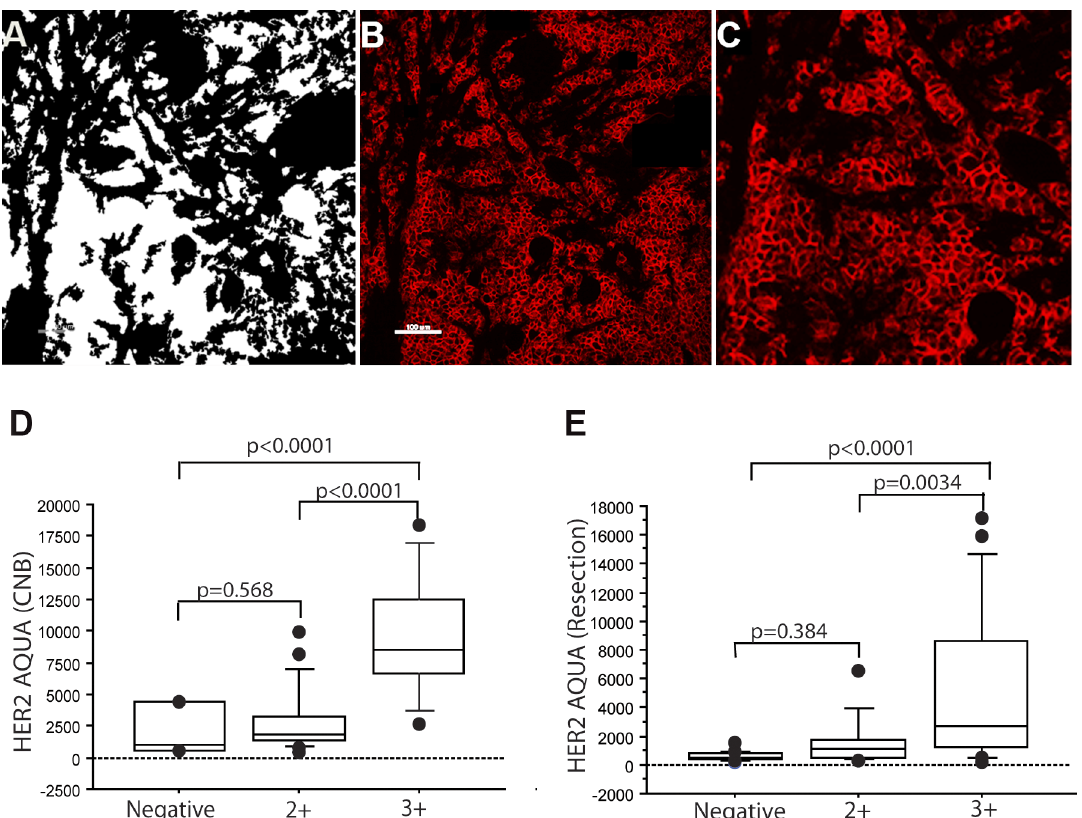
Figure 1. HER2 detection by immunofluorescence in control arrays, and concordance between HER2 AQUA vs. conventional HER2 IHC. A: Assignment of the tumor compartment as defined by cytokeratin and DAPI fluorescence in sections with invasive or DCIS lesions. B : Representative immunofluorescent staining of HER2. Original magnification, 20 6 . C : HER2 signal visualized with high magnification. D : box plots of the distribution of HER2 AQUA versus groups scored by clinical IHC criteria as HER2 negative, 2 + and 3 + evaluated on core needle biopsies (CNBs). E : box plots of the distribution of HER2 AQUA versus groups scored as clinically HER2 negative, 2 + and 3 + evaluated on resection specimens.